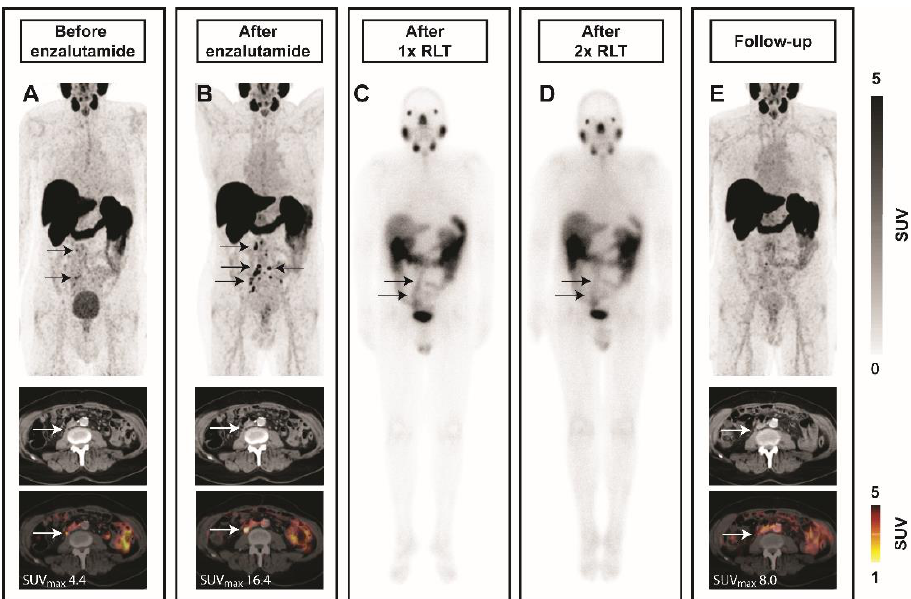
Figure 4. Enhanced PSMA levels under enzalutamide in a patient with low-PSMA nodal metastases. Images from an 81-year-old mCRPC patient are shown. At baseline, a few lymph node metastases with low 68 Ga-PSMA-11 uptake on PET/CT are present ( A , arrows). Patient started mCRPC treatment with enzalutamide. A follow-up 68 Ga-PSMA-11 PET/CT scan after five months showed progressive lymph node disease and increased 68 Ga-PSMA uptake ( B , arrows). Subsequently, two cycles of 7.4 GBq 177 Lu-PSMA radioligand therapy (RLT) were administered with decreasing uptake on the post-therapeutic scintigraphies ( C –first cycle, D –second cycle, arrows). Follow-up 68 Ga-PSMA-11 PET/CT was consistent with treatment response and demonstrated size decrease of tumor lesions along with reduced PSMA-ligand uptake ( E , arrows). Abbreviations: SUV, standardized uptake value.